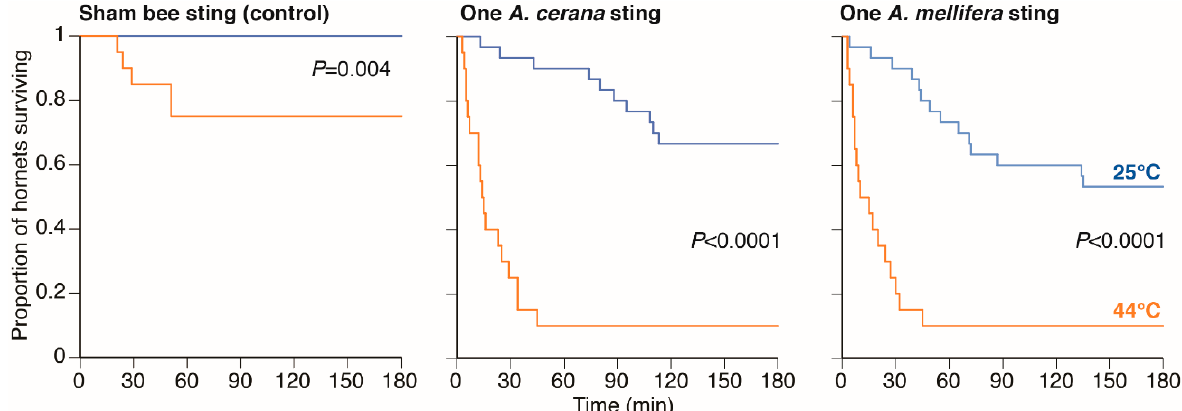
Figure 3. Effect of heat-balling temperature (=44 °C) and the species of bee sting upon hornet survival. The p -values derive from log-rank chi-square tests.